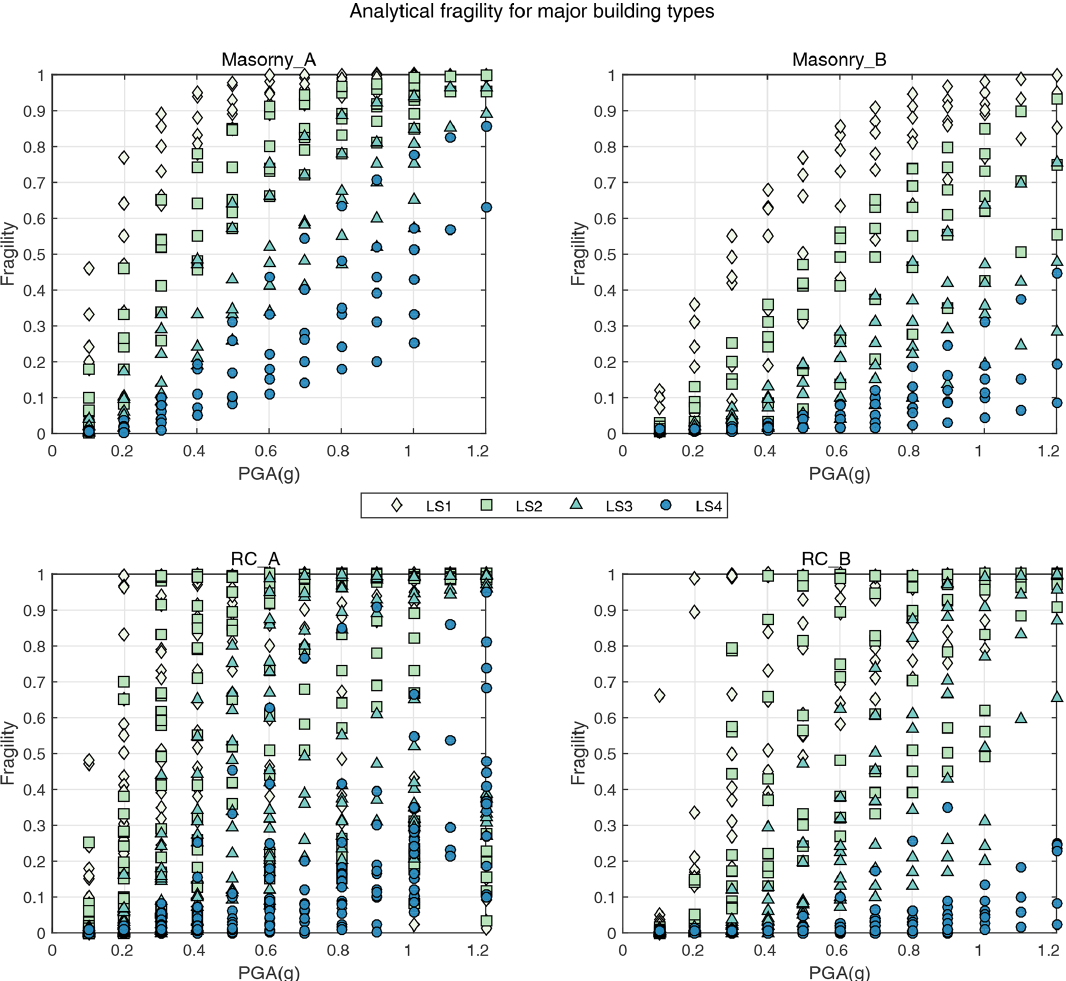
Figure 4. The distribution of analytical fragility data derived from nonlinear analyses, depicting the relation between the exceedance proba- bility of each damage limit state (LS1, LS2, LS3, LS4) at given PGA levels. The fragility datasets are grouped by building types (masonry and RC) and seismic resistance levels (A and